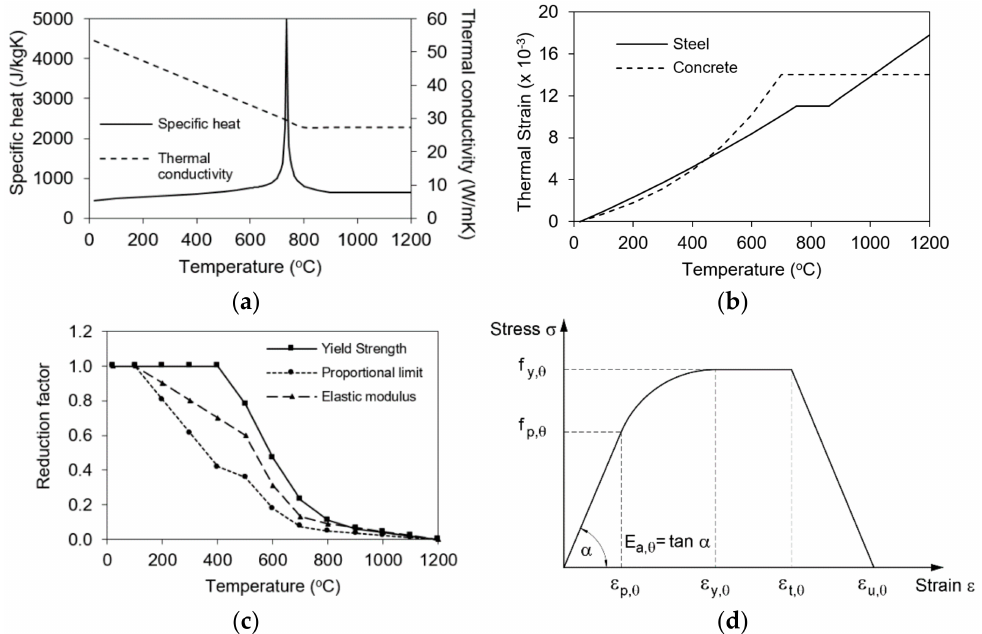
Figure 4. Material properties of steel at high temperature: ( a ) Specific heat and thermal conductivity; ( b ) Thermal elongation; ( c ) Strength and stiffness reduction factor; ( d ) Stress-strain curve at elevated temperature.